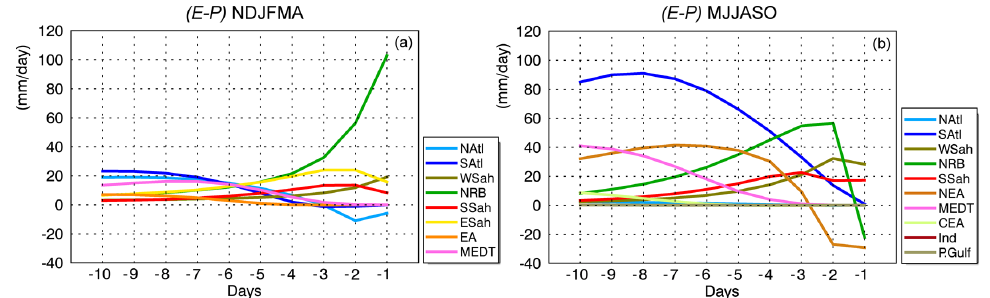
Figure 6. Climatological absolute daily (1–10 days) values of (E – P) integrated using a backward analysis from the NRB considering moisture sources for NDJFMA ( a ) and MJJASO ( b ) for the period 1980–2014. The acronyms of the sources regions correspond with those given in Figure 5.